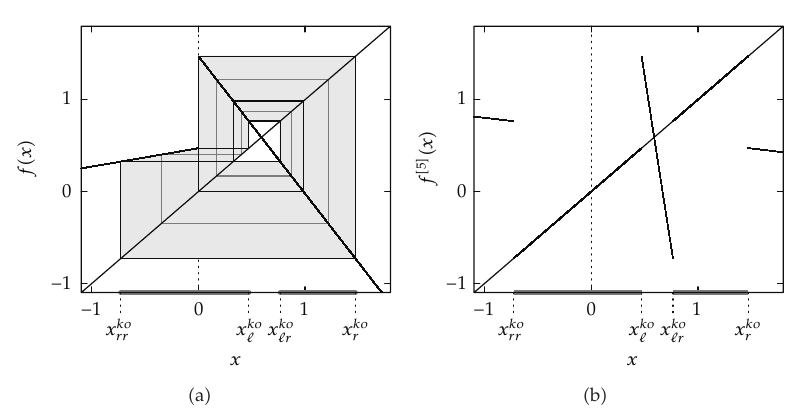
Figure 12: Behavior at the big bang bifurcation point ζ LR 4 : system function (cid:7) a (cid:8) and its fifth iterated (cid:7) b (cid:8) . On the horizontal axis the absorbing set containing an infinite number of coexisting neutral orbits O LR 4 is marked. In (cid:7) a (cid:8) three orbits are shown: two kneading orbits (cid:7) in other words, the orbits O LR 4 undergoing border collision bifurcation (cid:8) and one orbit located between them, which does not undergo a border collision